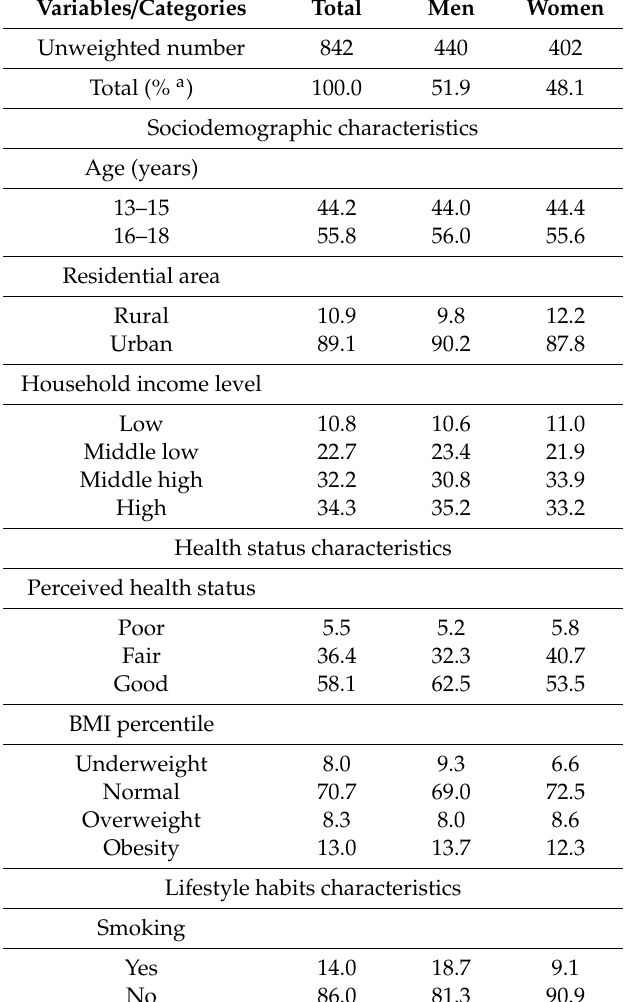
Table 1. General characteristics of the